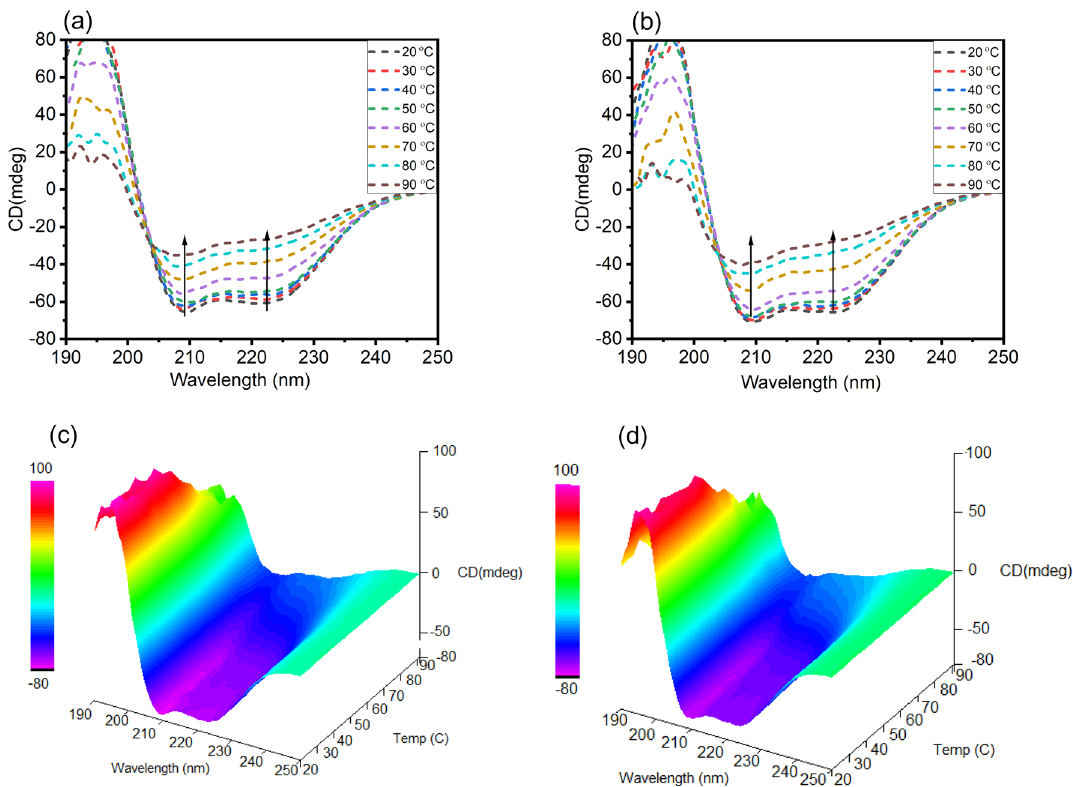
Figure 7. Far-UV CD spectra of (a) HSA alone, (b) HSA in the presence of trans -resveratrol (20 µM) as a function of temperature ranging from 20 to 90 °C. Three dimensional far-UV CD spectra of (c) HSA alone and (d) HSA in the presence of trans -resveratrol (20 µM) as a function of temperature ranging from 20 to 90 °C.